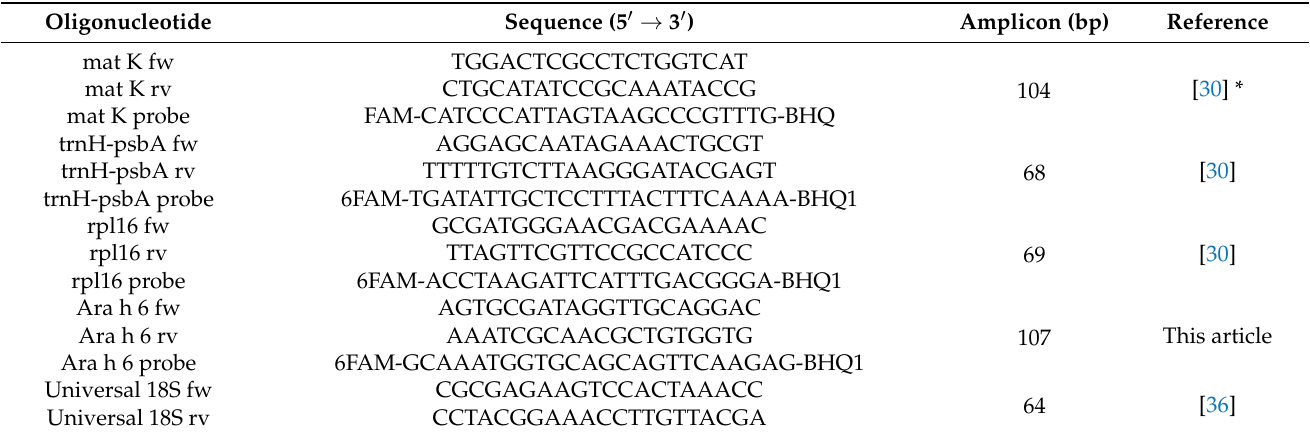
Table 1. DNA sequences of primers and